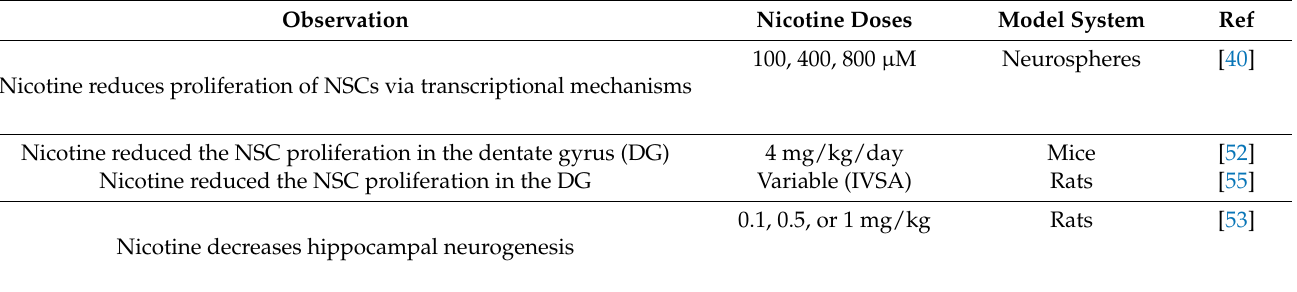
Table 1. Summary of nicotine-related decreases in neural stem cells (NSC)